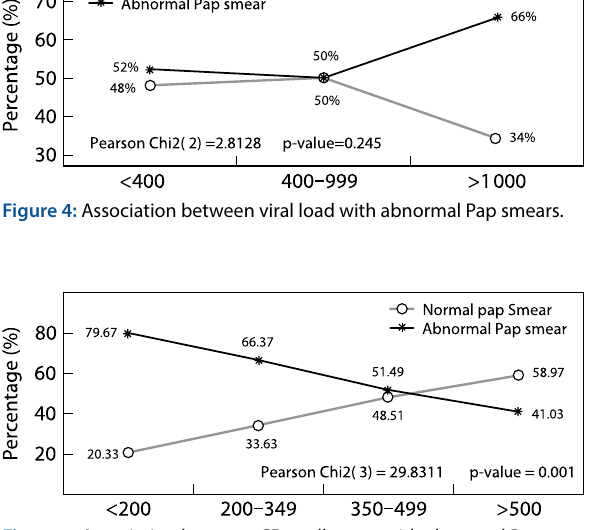
Table 3: Clinical characteristics of the study’s participants